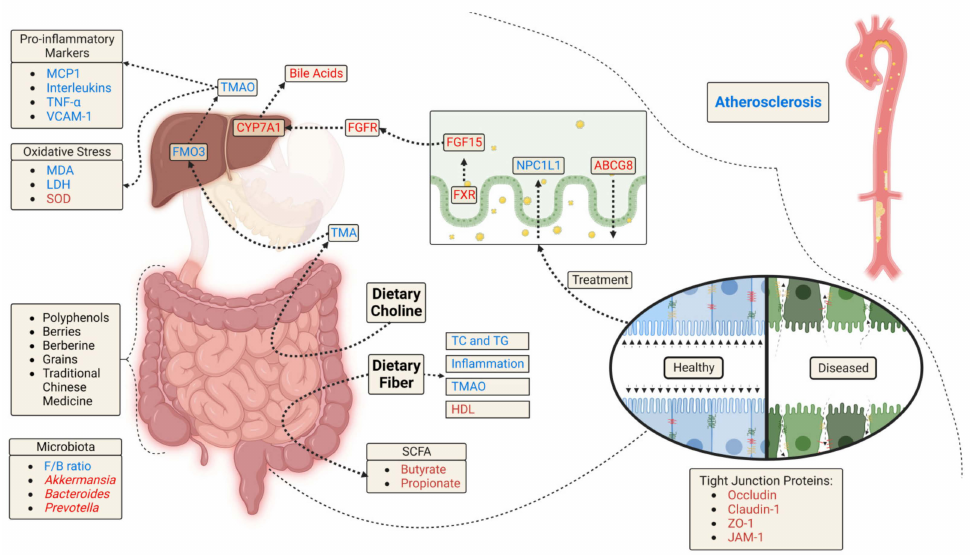
Figure 4. Mechanisms regulating plaque by the microbiome. Nutritional interventions reduced plaque in the aorta of mice by modulating the microbiome. The F/B ratio was reduced while the relative abundance of Akkermansia , Bacteroides, and Prevotella was upregulated. Changes in the microbiome were associated with increases in SCFAs levels and bile acid excretion in the liver, likely mediated by upregulation of CYP7A1. Lower levels of TMA and TMAO also correlated with reduced inflammation and oxidative stress in circulation and with reduced gut barrier permeability. Red signifies upregulation and blue downregulation in expression mediated by nutritional interventions. Created with BioRender.com (accessed on 8 February